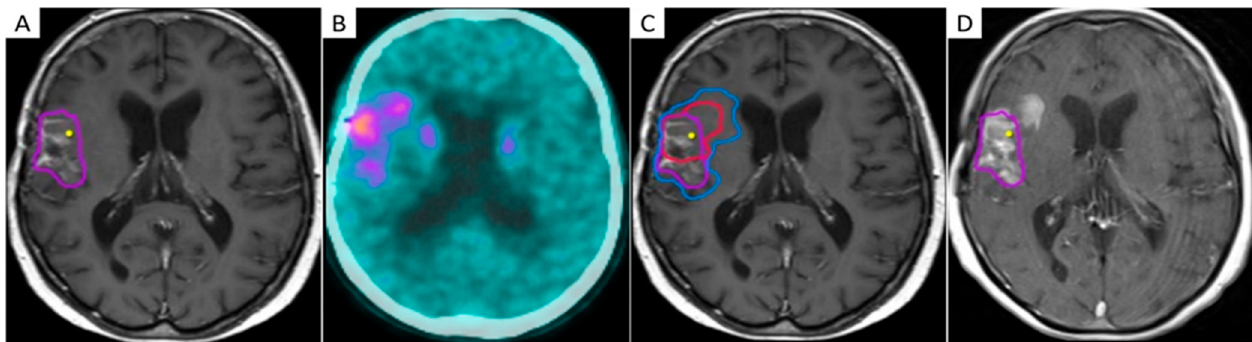
Figure 5. Integration of F-DOPA PET/CT in a LINAC-based radiosurgical planning of a 55-year-old female patient with recurrent GBM. ( A ) shows GTV based on contrast-enhanced T1-weighted MRI images; ( B ) shows remarkable F-DOPA uptake extending beyond contrast-enhancement. The final target volume was delineated by taking into account the F-DOPA-positive signal ( C ). Three-month follow-up ( D ) shows tumor progression at the site of pre-RT increased F-DOPA uptake, despite salvage irradiation.